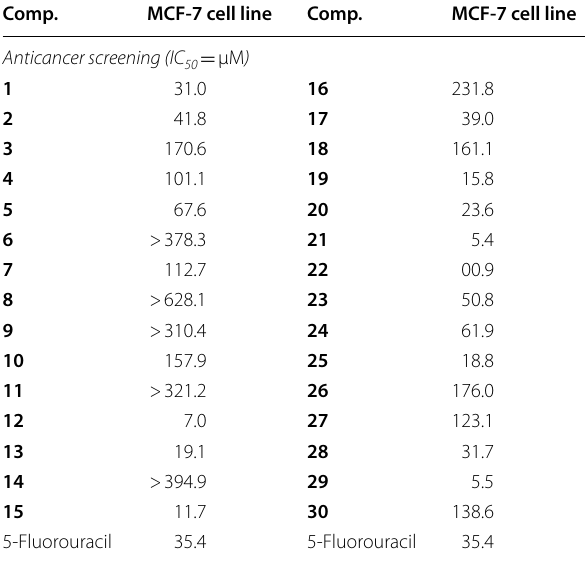
Table 2 Anticancer screening results of synthesized compounds